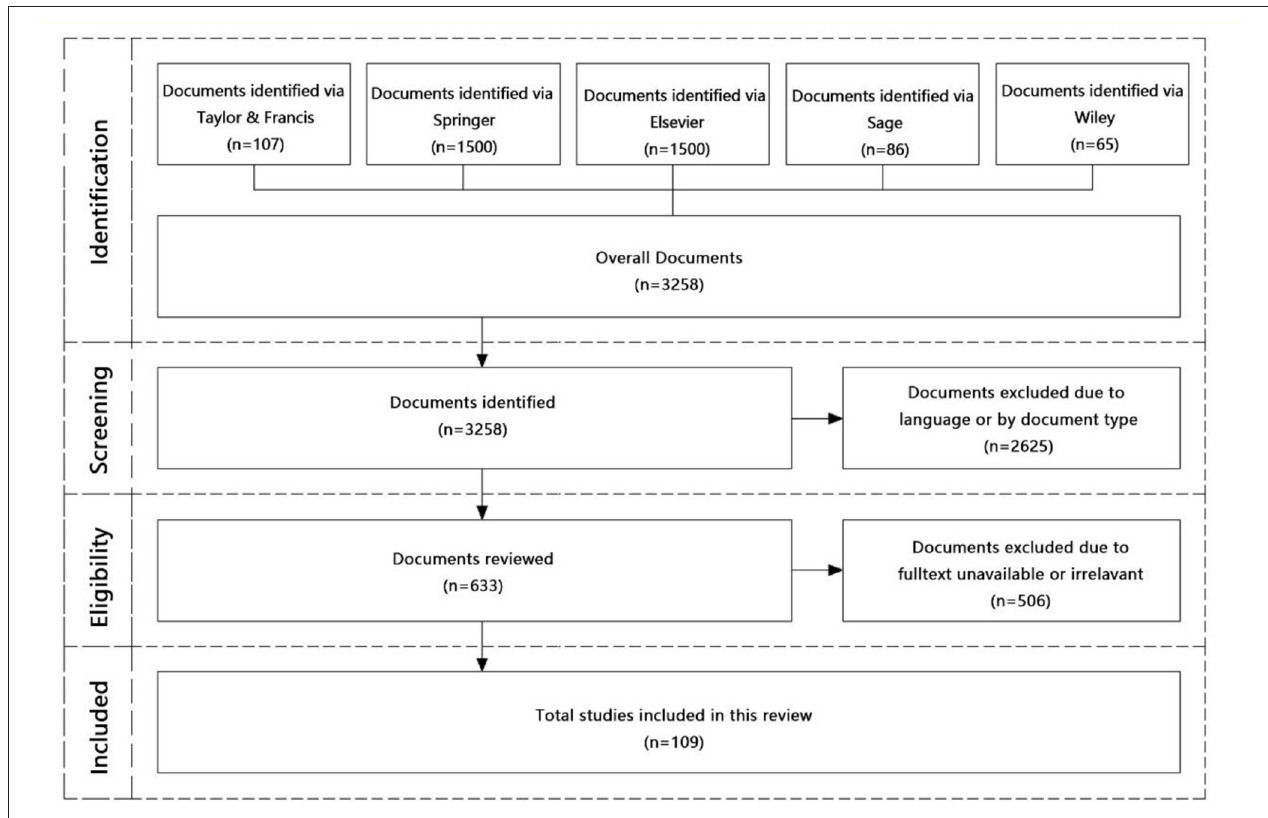
FIGURE 3 | Method of review.